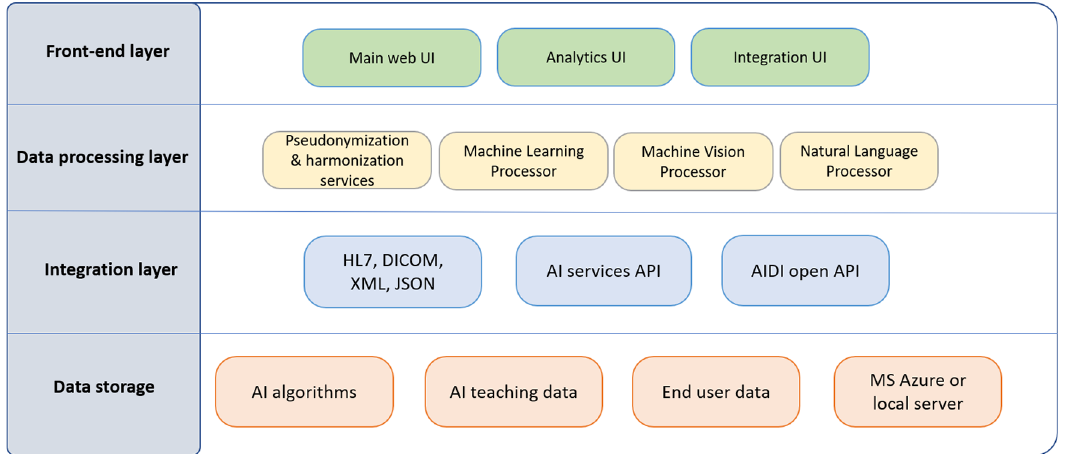
Figure 2. AIDI technology